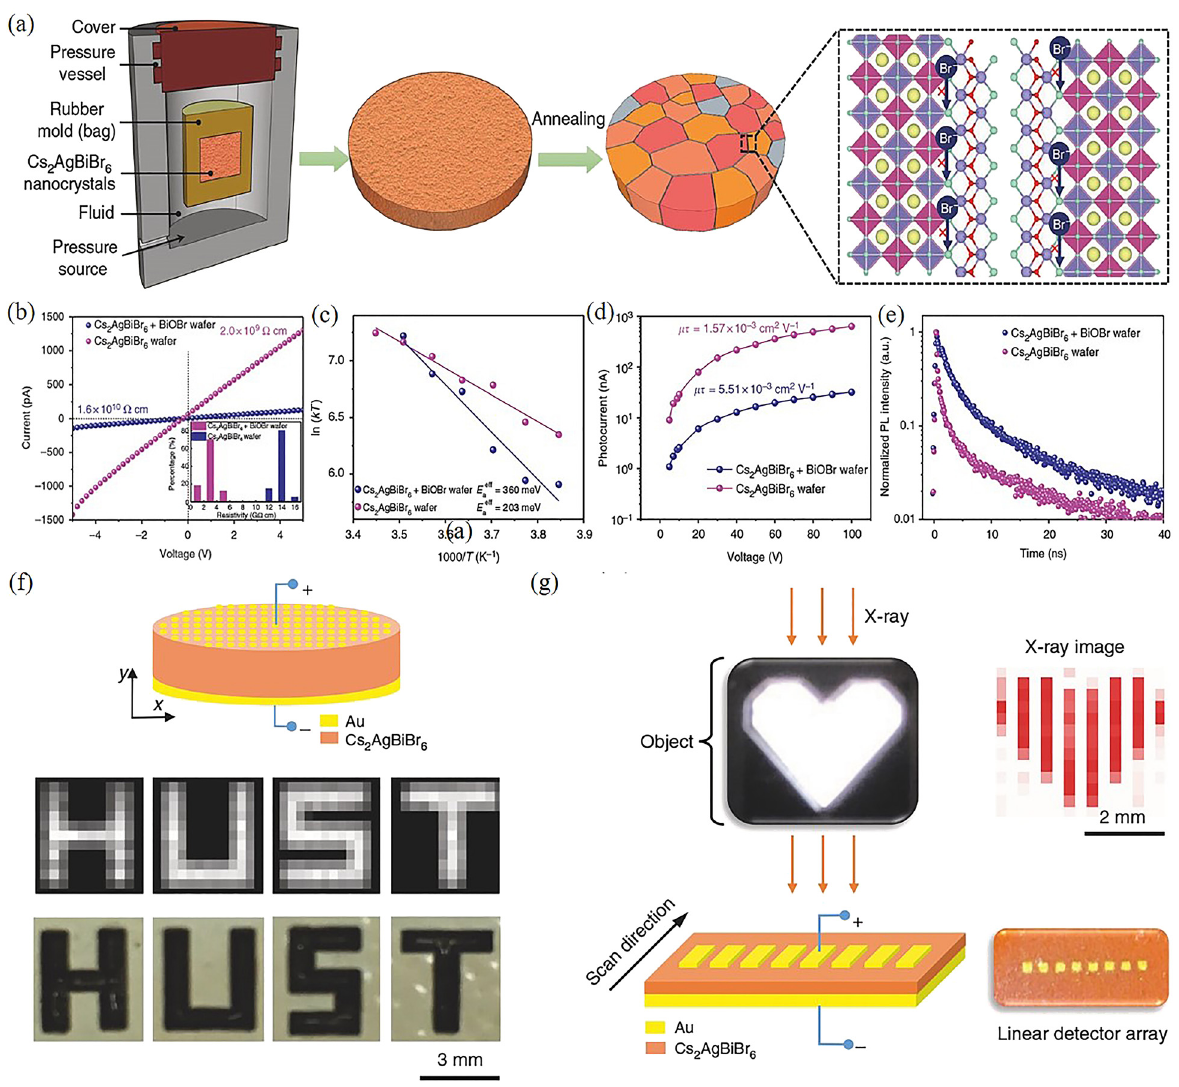
Figure 10: Polycrystalline Cs 2 AgBiBr 6 wafer for X-ray detection. (a) Schematic diagram of the preparation method of the Cs 2 AgBiBr 6 wafer. Isostatic-pressing with a 200 MPa hydraulic press is used to